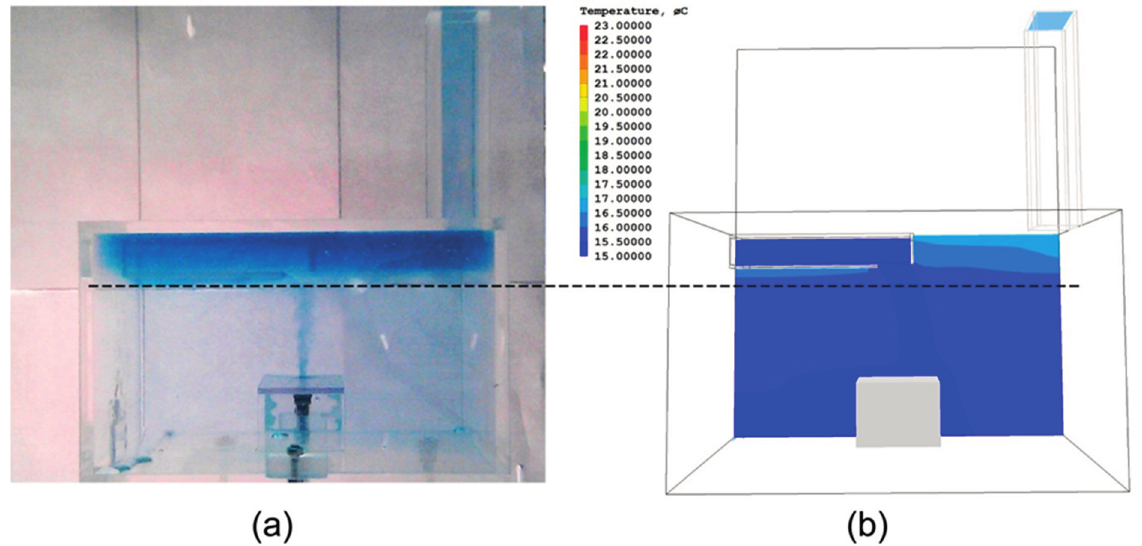
Figure 2. Compared interface layers in: ( a ) Salt-bath model; and ( b ) Computational fluid dynamics (CFD) model